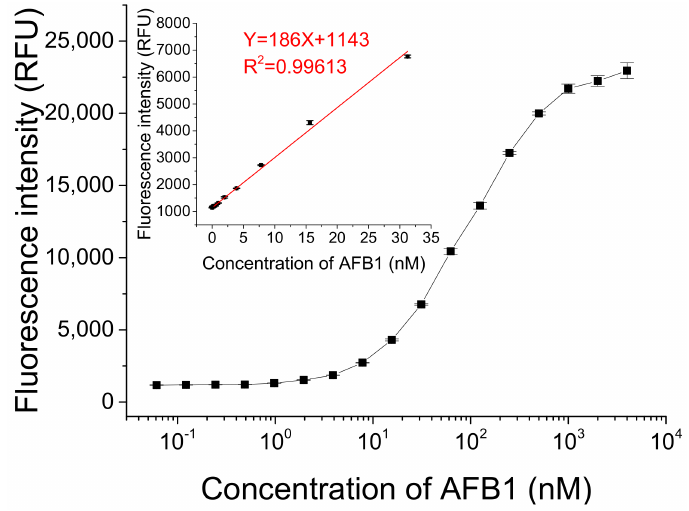
Figure 5. Detection of different concentrations of AFB1 using this fluorescent switch aptasensor. As- say buffer contained 10 mM Tris-HCl (pH 7.5) solution, 50 mM MgCl 2 , 50 mM NaCl, and 0.1% Tween20. Af27 and Af27-C13Q were used as aptamer and QDNA, respectively. The ratio of C FDNA : C Aptamer : C QDNA was 50 nM:100 nM:150 nM. Incubation at 4 ◦ C for 60 min was